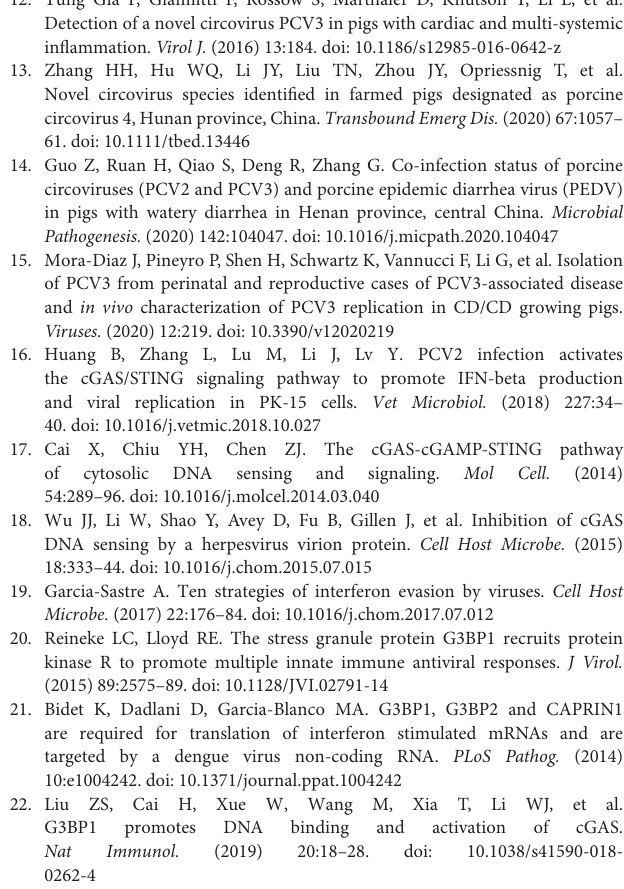
Supplementary Figure 1 | Model showing how Cap antagonizes the action of IFNs. Schematic showing the mechanism underlying Cap inhibition of the cGAS-STING signaling pathway. The interaction between Cap and G3BP1 competes with cGAS for binding to G3BP1 and prevents cGAS from recognizing DNA, thereby inhibiting the production of